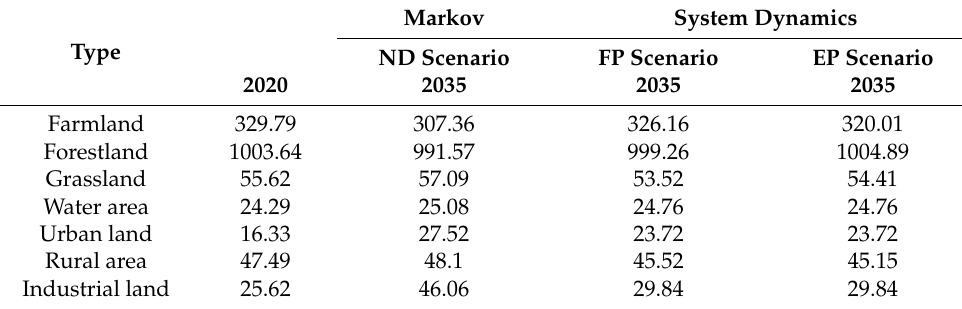
Table 4. Land-use demand projection of 2035 under different scenarios (km 2